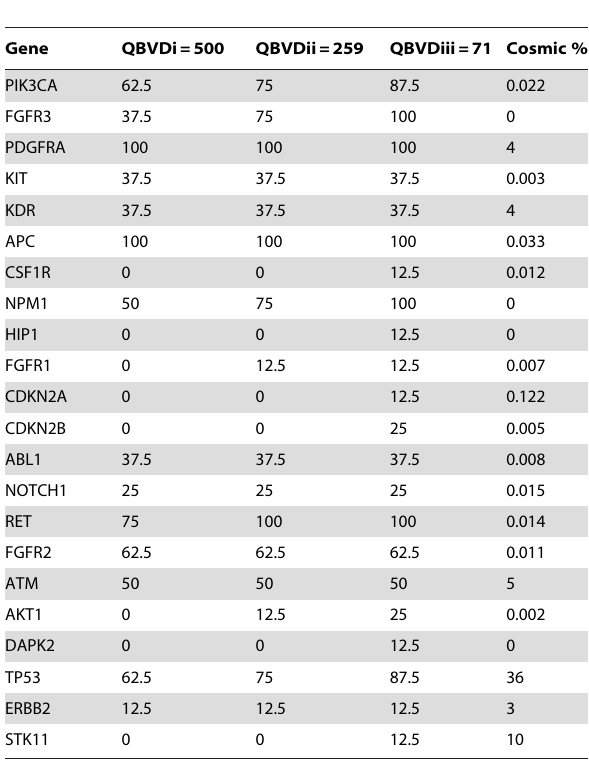
The proportion (%) of lung adenocarcinoma samples harbouring mutations in the other genes interrogated by the panel and the resultant application of different detection thresholds. Frequencies were compared with that observed in the COSMIC